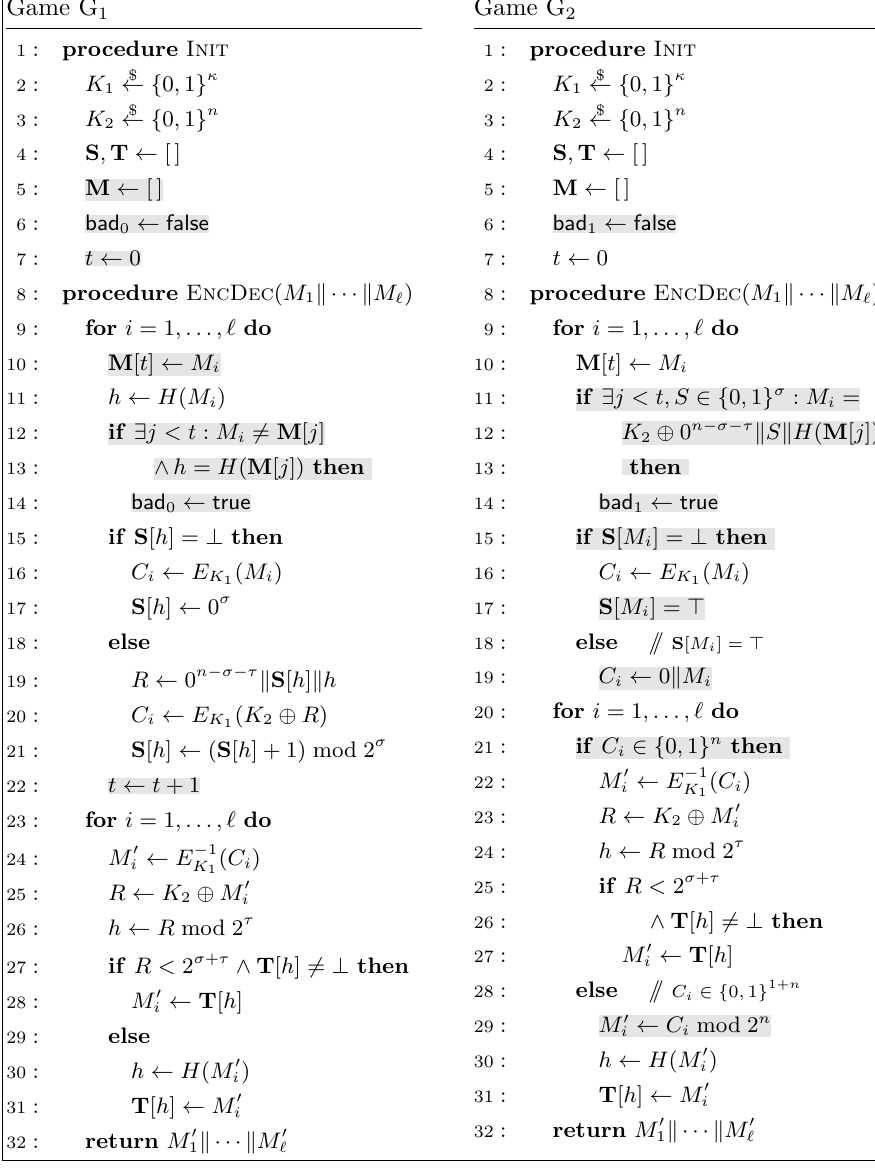
, and changes and additions 1 2